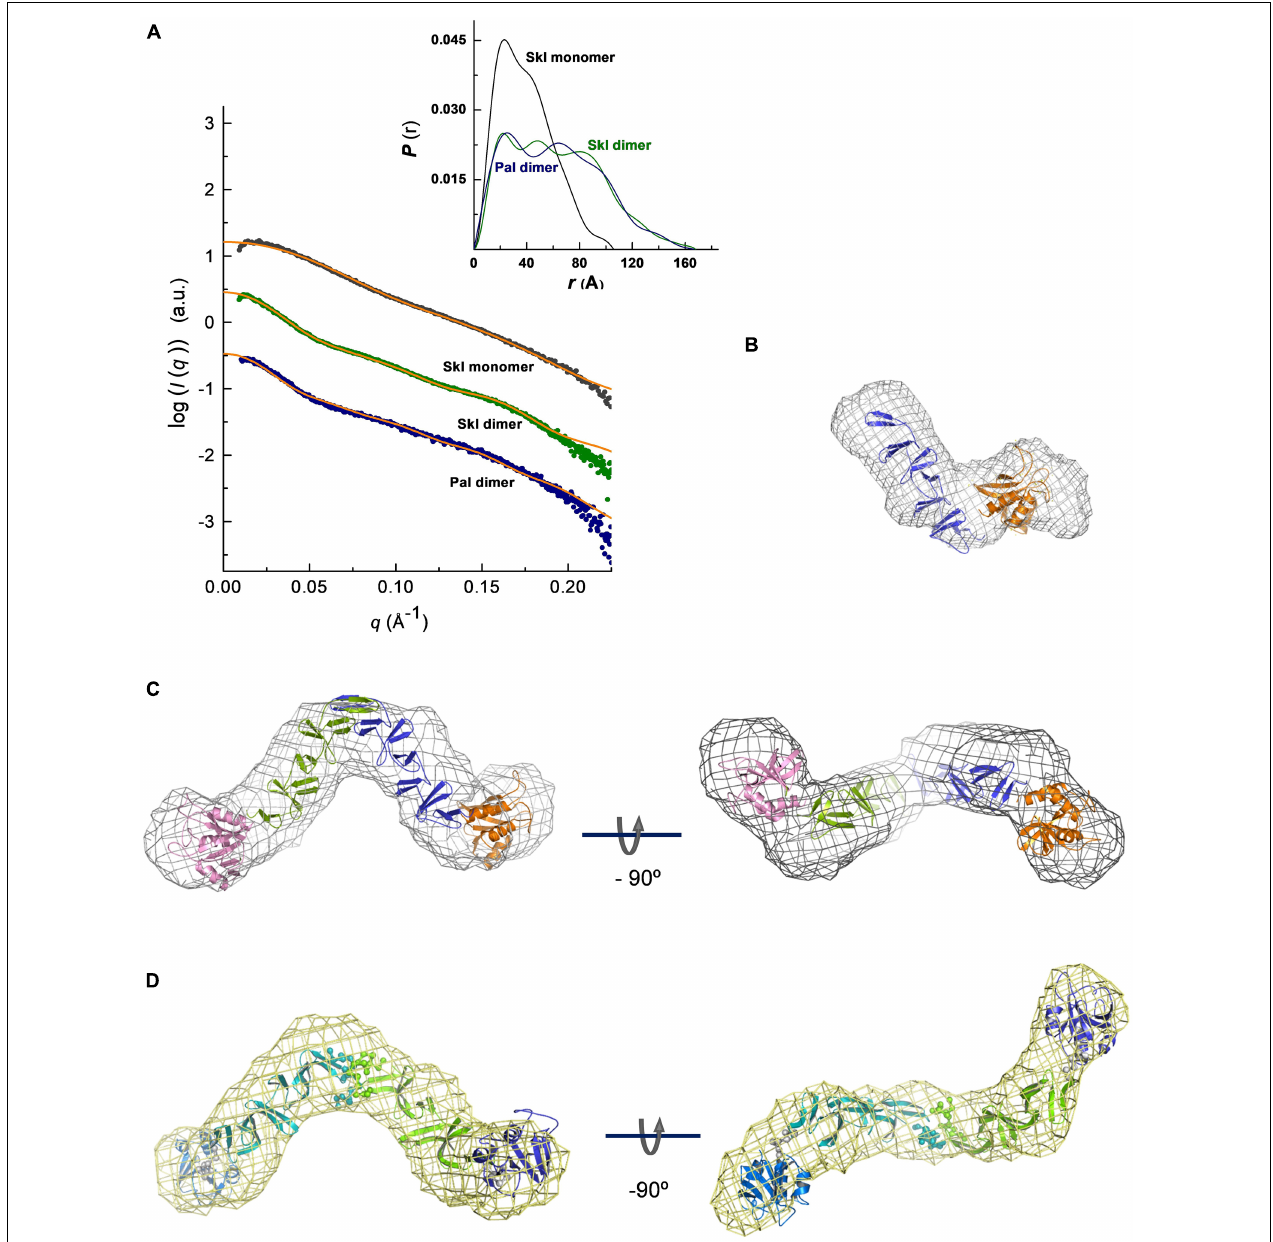
FIGURE 6 | SAXS-based overall structures of Pal and Skl NAM-amidases. (A) Overlay of the scattering curves at infinite dilution of Skl and Pal (symbols) with the fits obtained by rigid-body modeling (orange traces). χ 2 values between experimental and theoretical data calculated with CRYSOL were 0.646 (Skl), 0.512 (Skl/choline), and 0.153 (Pal/choline). The inset shows the real-space distance-distribution functions P (r), calculated with GNOM, for the respective configurations in solution. (B–D) Ab initio models built with DAMMIF/DAMMIN (mesh representation) superimposed with best rigid models (cartoon representation) of the Skl monomer (B) , dimer (C), and Pal dimer (D) . Views of rigid-body models of Pal and Skl dimers unveil the trans configurations of the NAM-amidase domains located at the extremes of the molecule (N-Skl: orange and pink domains; N-Pal: blue and violet domains; spheres depict dummy residues assigned to avoid clashes at the dimer interface and linker amino acids). Measurements were made at 4 ◦ C in 20 mM PB (Pal) or 50 mM Tris–HCl (Skl) at pH 8.0, supplemented or not with